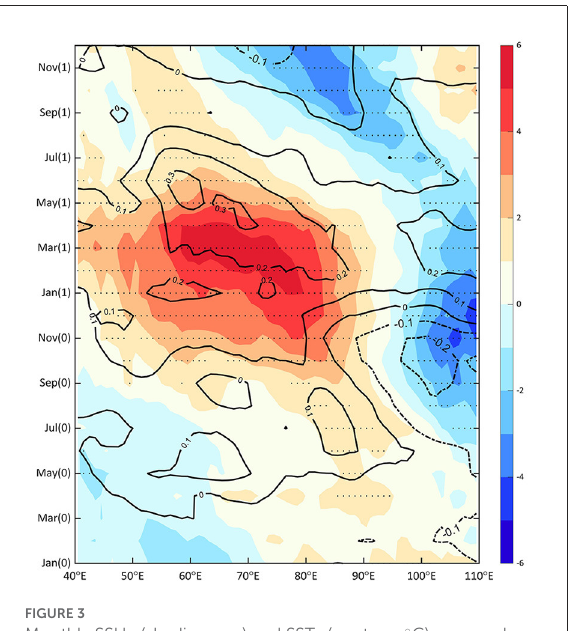
FIGURE3 Monthly SSHa (shading, cm) and SSTa (contour, ◦ C) averaged over 5 ◦ S − 15 ◦ S regressed onto NDJ Niño 3.4 SST for 1993/94-2019/20. Stippling indicates confidence level > 95% for SSHa based on students’ t-test. Based on CMEMS SSH from 1993-2020 and OISST from 1982-2021, after removing the linear trend and seasonal